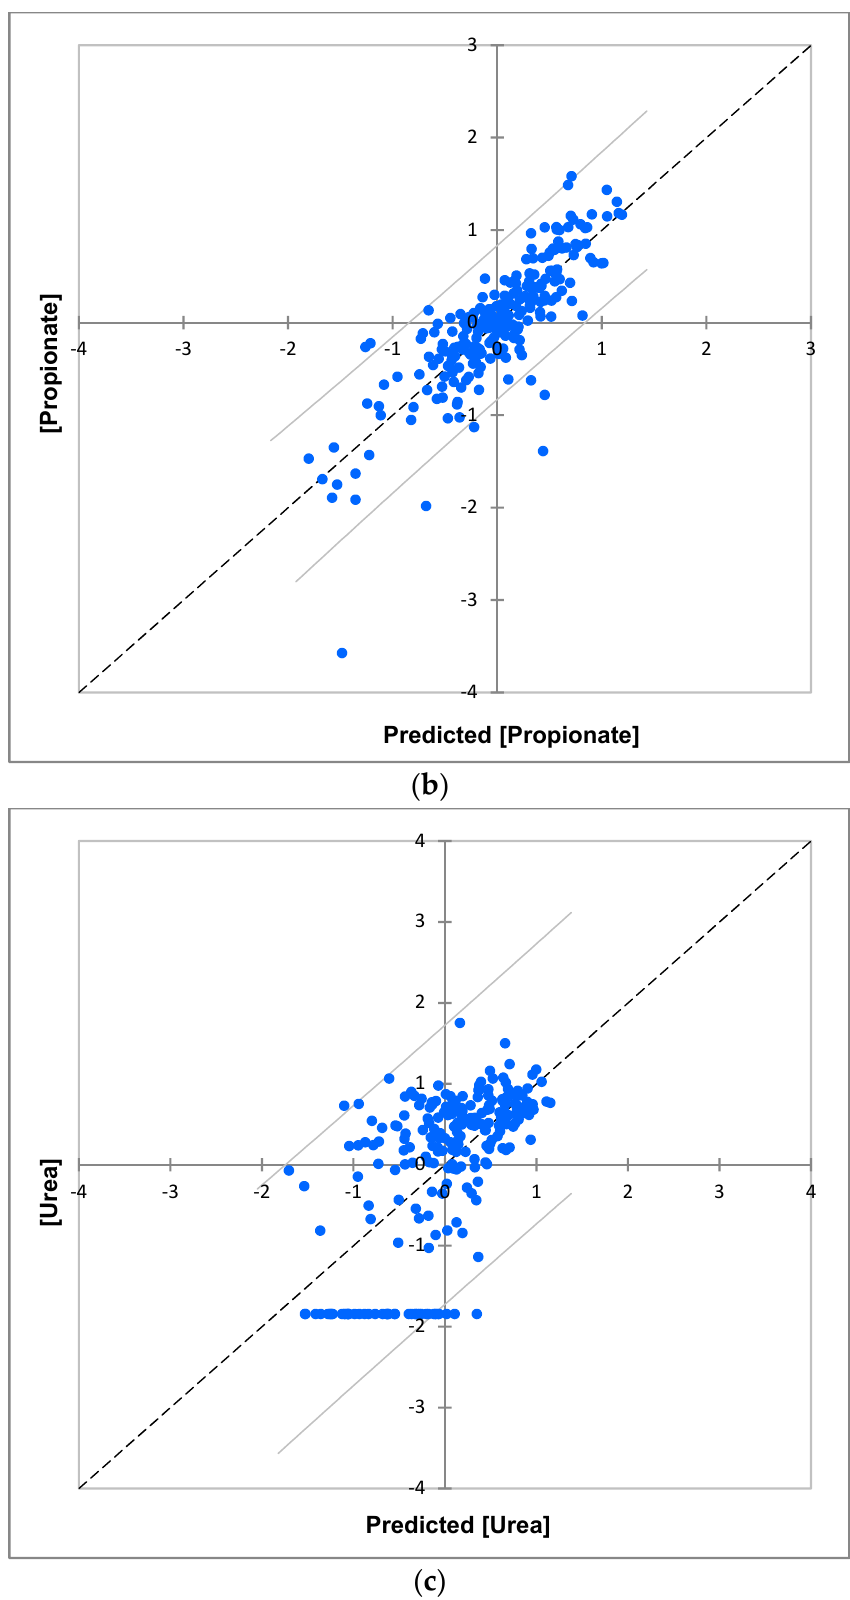
Figure 8. Plots of observed metabolite concentrations vs. that predicted from the ANOVA-based experimental design model shown in Equation (3) for ( a ) n -butyrate, ( b ) propionate, and ( c ) urea. Biomolecule concentrations were glog-transformed and Pareto-scaled prior to statistical analysis.